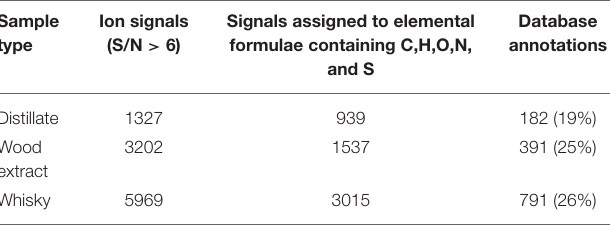
TABLE 1 | Number of signals, assigned molecular formulae and database hits found for mass spectra of the distillate, the whisky from the same distillery and a wood